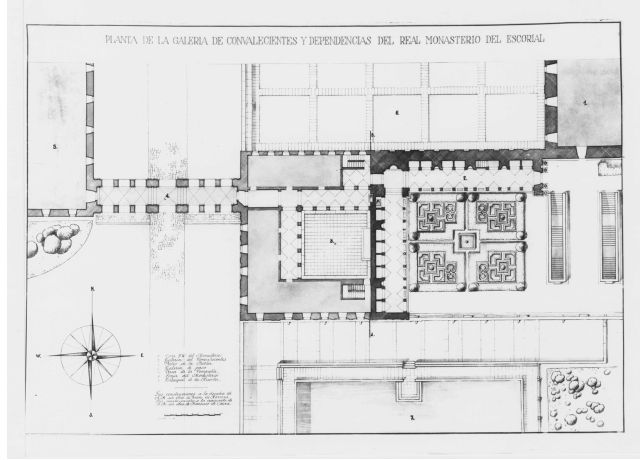
Figure 3. Manuel Lorente, 1944: Planta de la Galería de Convalecientes y dependencias del Real Monasterio del Escorial . Colegio Oficial de Arquitectos de Madrid (Spain), Servicio Histórico, Legado Lorente Junquera, Bookmark MLJ/P01/B3-1-01.